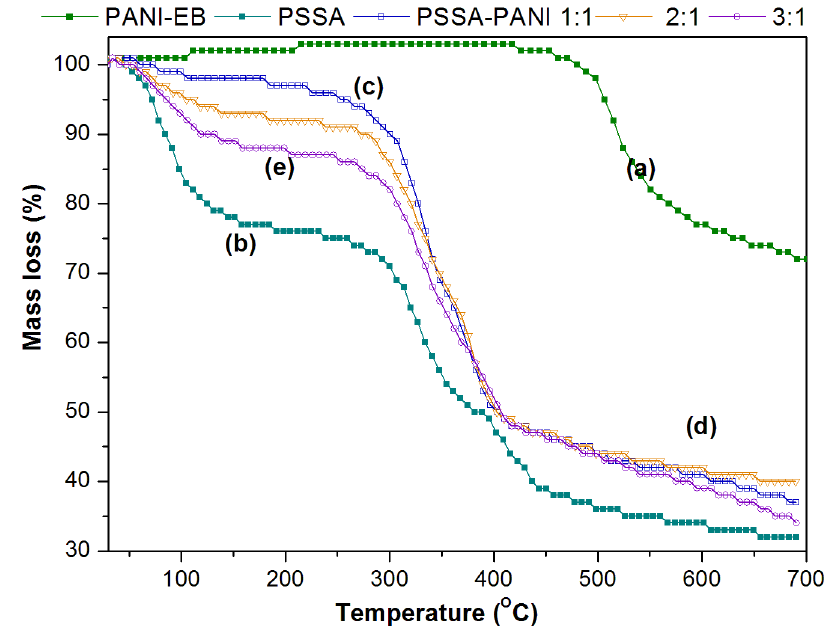
Figure 4: Recorded TG (a) and DTG (b) pattern for (a) PANI-EB, (b) PSSA and PSSA-PANI at (c) 1:1, (d) 2:1, (e) 3:1 molar